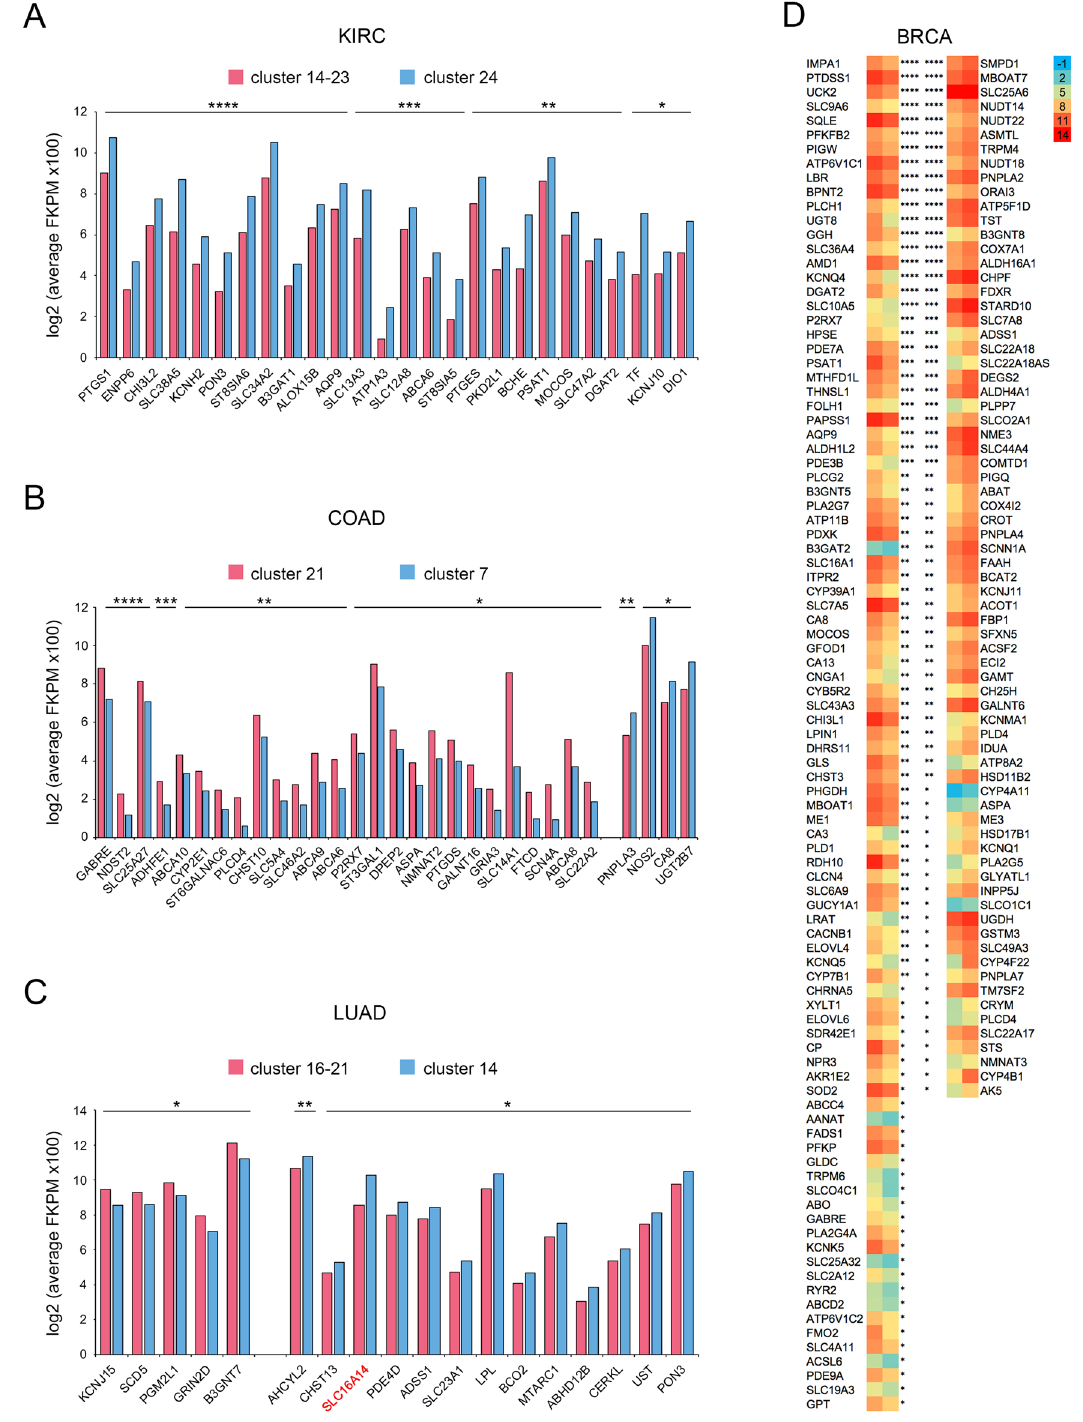
Figure 5. Metabolic enzymes with expressions that differentiate worse from better prognosis cancer subtypes. ( A,B ) Only those enzymes are shown with expression ratio of worse prognosis (red) over better prognosis (blue) of ≥ 2.0 and ≤ 0.5. ( C ) Only SLC16A14 falls into the range of ratios of ( A , B ). All others fall into smaller (2.0 ≥ 1.5) and larger (0.7 ≥ 0.5) ratios. ( D ) Same ratio ranges as ( A , B ) with left column ≥ 2.0 and right column ≤ 0.5. The left squares of both columns are of cancer subtypes with worse prognoses (clone 9) while those on the right are of cancer subtypes with better prognosis (clone 7). p < 0.05 (*), p < 0.01 (**), p < 0.001 (***), p < 0.0001